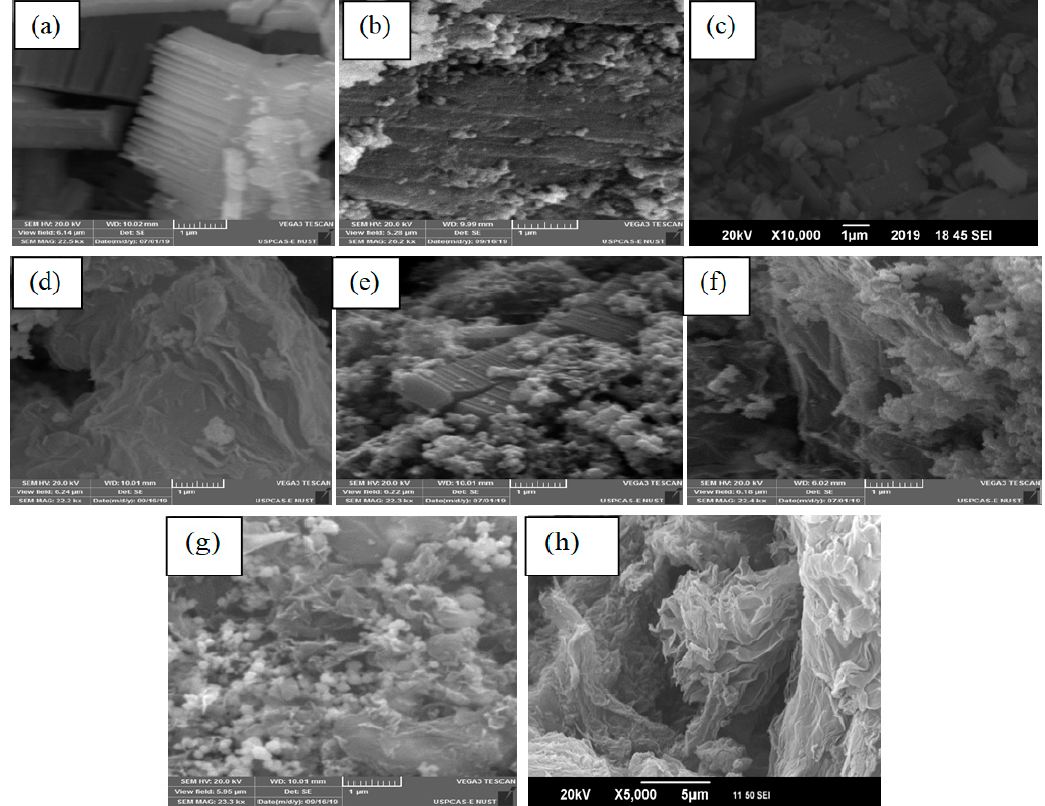
Figure 3. Powder XRD of ( a ) NiO/CuO MOF, 1 wt% rGO–NiO/CuO MOF, 2 wt% rGO–NiO/CuO MOF, 3 wt% rGO–NiO/CuO MOF, 4 wt% rGO–NiO/CuO MOF, 5 wt% rGO–NiO/CuO MOF and 8 wt% rGO–NiO/CuO MOF ( b ) graphene oxide ( c ) reduced graphene oxide.